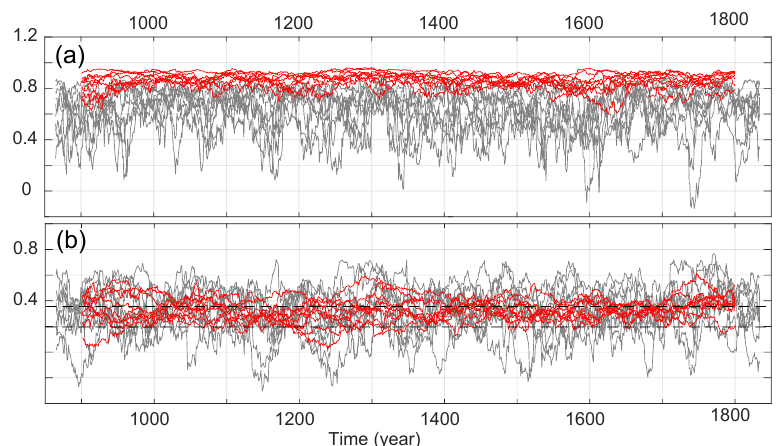
Figure 8. (a) RPCs and (b) RCs in nine CESM-LME full-forcing experiments. Gray (red) lines represent 31-year (101-year) RPCs/RCs. Dashed lines in panel (b) represent the 95% significance test for 31-year (upper) and 101-year (lower) RCs. Note that the RCs in panel (b) are calculated between the EASM strength and regionally averaged (35–45 ◦ N, 105–120 ◦ E) summer precipitation.